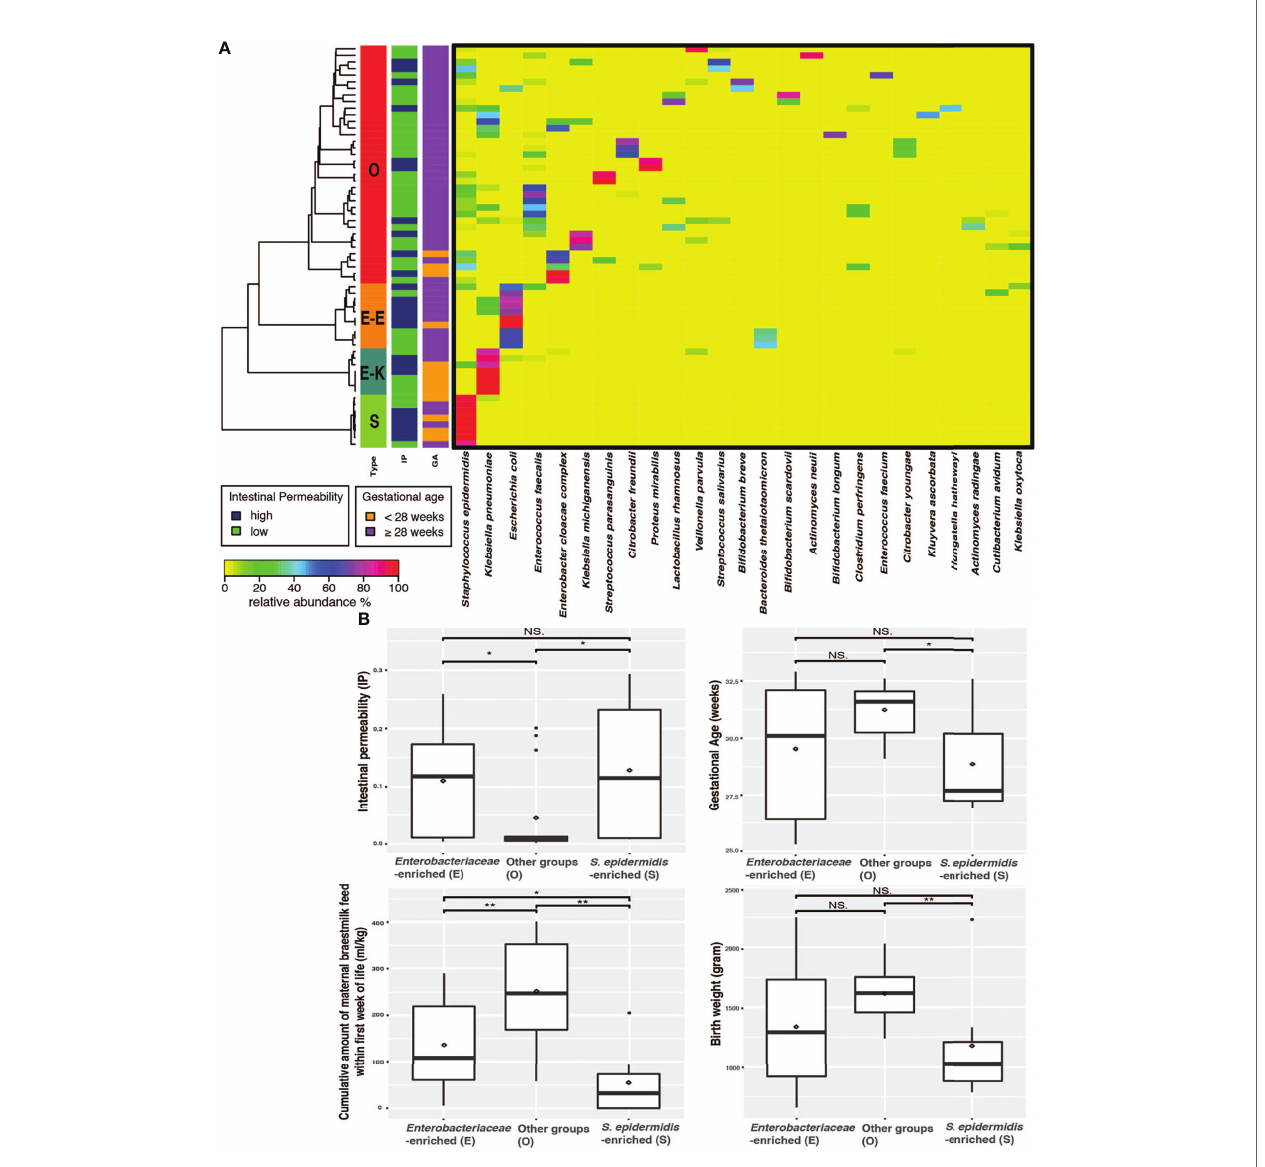
FIGURE 1 | Preterm infants exhibited three distinct microbiome types. (A) Heatmap of the 25 most abundant intestinal bacterial taxa and their relative abundance in samples collected from 38 preterm infants enrolled in the study. The taxonomic composition of the microbiomes used the data set of whole community metagenomic sequencing and the pro fi le was generated by MetaPhlAn version 2 (40). Statistical signi fi cance was calculated using Wilcoxon rank sum test using ggsignif R package (41). Ward linkage clustering was used to cluster samples based on their Jensen-Shannon distance calculated in vegan package in R (42). The number of clusters was validated using gap statistics implemented in the cluster package in R (43) by calculating the goodness of clustering measure. (B) Boxplots of IP, GA, MOM, and BW depicting distribution of microbiota types in fecal samples of preterm newborns. Signi fi cance value was calculated using Wilcoxon rank sum test. *p < 0.05, **p < 0.01. Plotted are interquartile ranges (IQRs, boxes), medians (line in box), and mean (red diamond). IP, intestinal permeability; GA, gestational age; NS., not signi fi